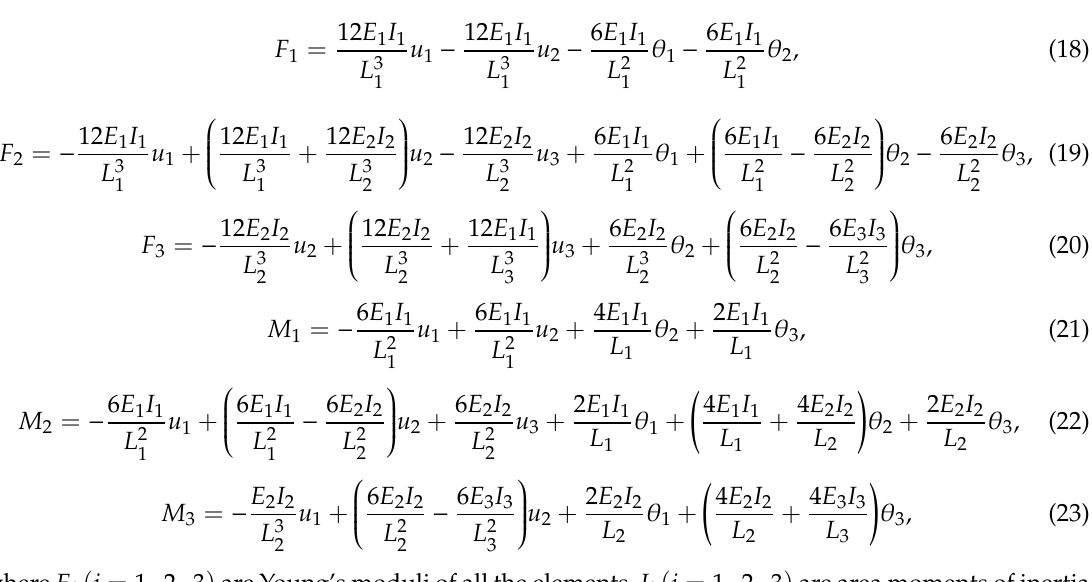
Figure 6. Simpler MDOF model of the VAWTs with only three nodes.